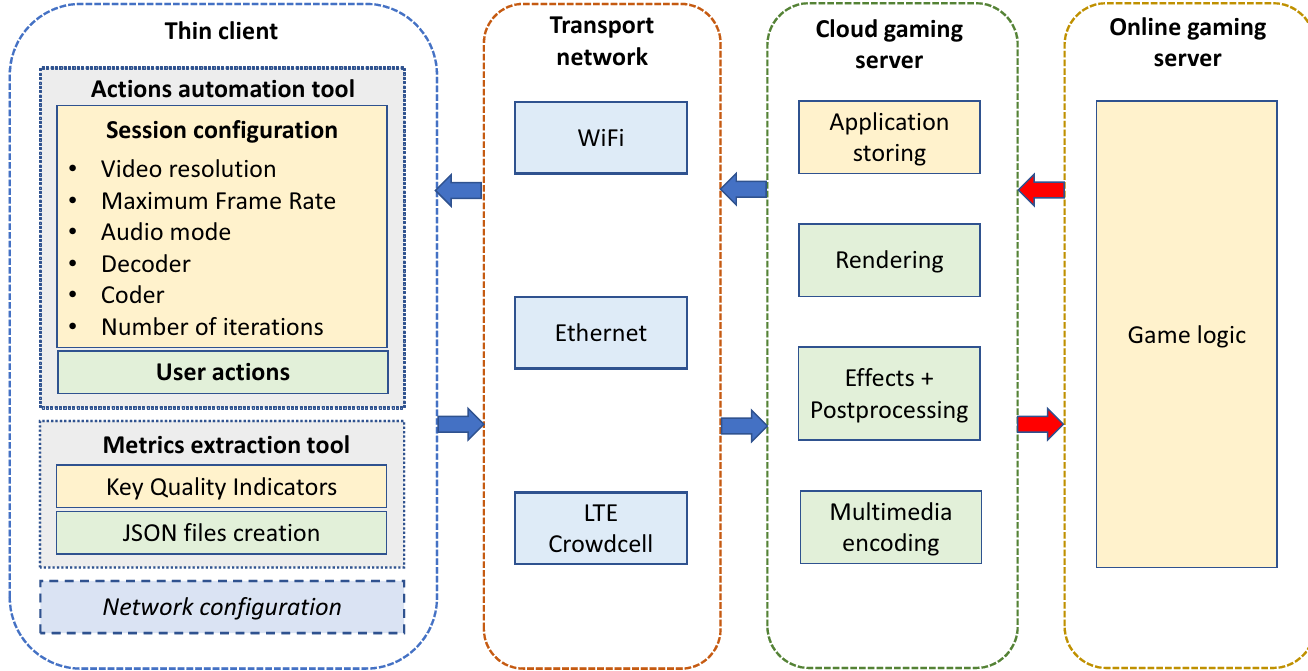
Figure 2. Cloud Gaming system